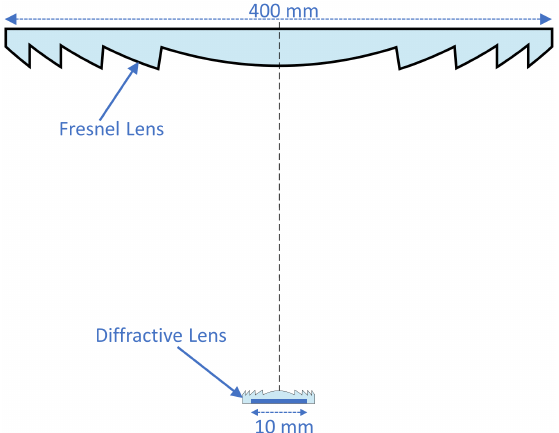
Figure 2. Schematic drawing of the designed high-concentration photovoltaics (HCPV) system with a diffractive secondary optical element. (Not drawn to